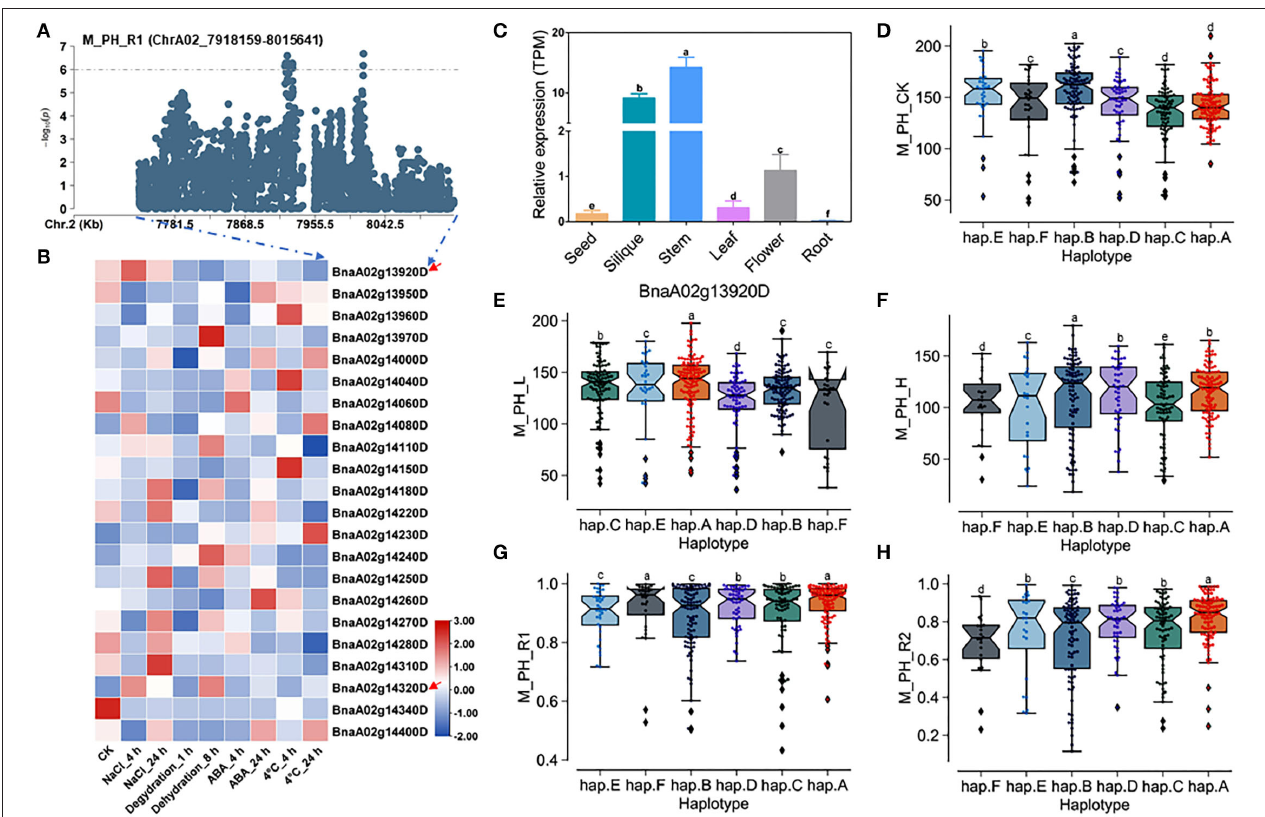
FIGURE 5 | Analysis of candidate genes within the QTL qSAT.A02.2 on ChrA02 associated with M_PH_R1. (A) A zoom-in view of the Manhattan plot on ChrA02 from 7,718,159 to 8,215,641 bp in the QTL qSAT.A02.2 region. These points represented the log-transformed P -values for variants from GWAS for the ratio of plant height between low-salt-alkali and control conditions at the mature stage (M_PH_R1). (B) Gene expression of candidate genes identified within 200kb upstream or downstream of the significantly associated SNPs under 200-mM NaCl, 25- µ M ABA, 4 ◦ C low temperature conditions for 4 and 24h and the dehydration condition for 1 and 8h in B. naps cultivar “ ZS11 .” (C) Expression levels of BnA02g13920D in different tissues of B. napus cultivar “ ZS11 .” Values were means ± SD ( n = 3 replicates), and different letters significantly indicate differences at p < 0.05 using two-way ANOVA. (D–F) Boxplots of haplotypes of BnA02g13920D for absolute value of the plant height (M_PH) at the mature stage under control conditions (M_PH_CK, D ), the low-salt-alkali condition (M_PH_L, E ), and under the high salt-alkali condition (M_PH_H, F ). Values were means ± SD ( n = 5 replicates), and different letters significantly indicate difference at p < 0.05 using two-way ANOVA. (G,H) Boxplots of haplotypes of BnA02g13920D for relative value of the plant height (M_PH) at the mature stage under the low-salt-alkali condition (M_PH_R1, G ) and under the high-salt-alkali condition (M_PH_R2, H ). Values were means ± SD ( n = 5 replicates), and different letters significantly indicate differences at p < 0.05 using two-way